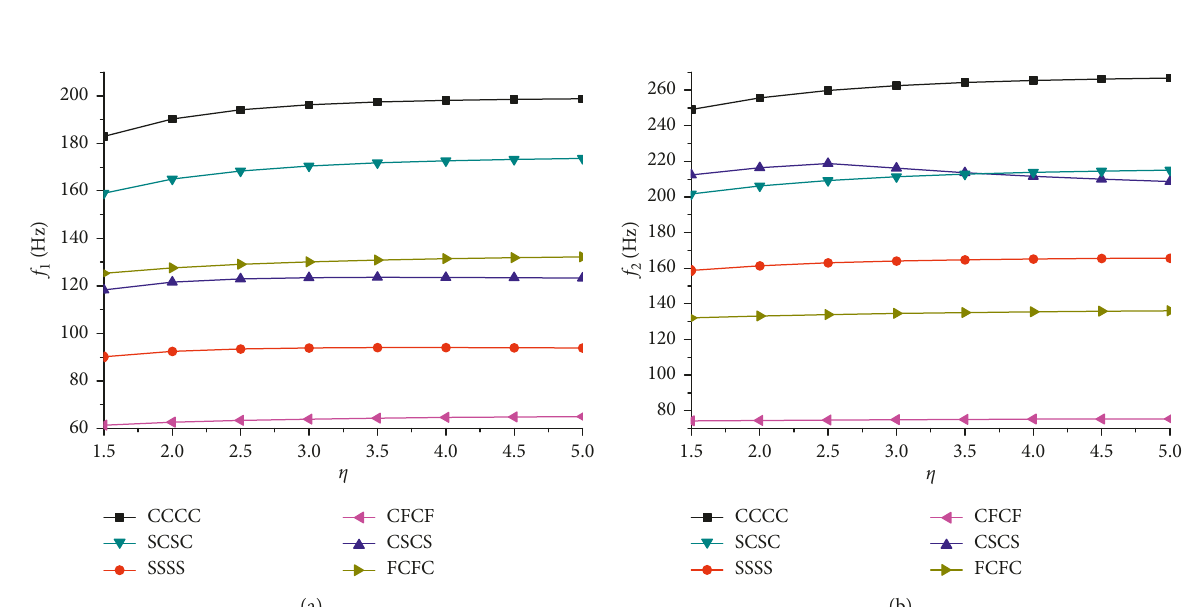
Figure 9: Variations of the natural frequencies of a rectangular plate supposed differently with various η .